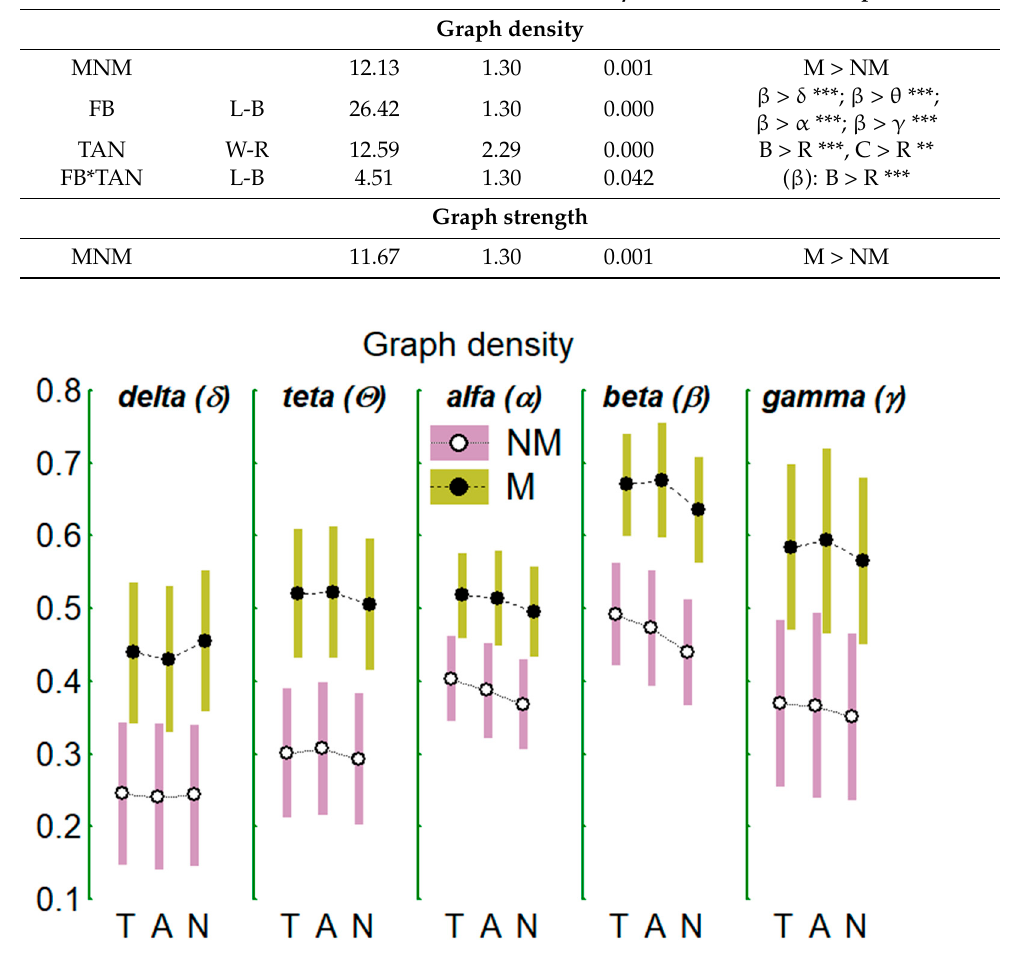
Figure 6. As in Figure 5 but for the density of the EEG